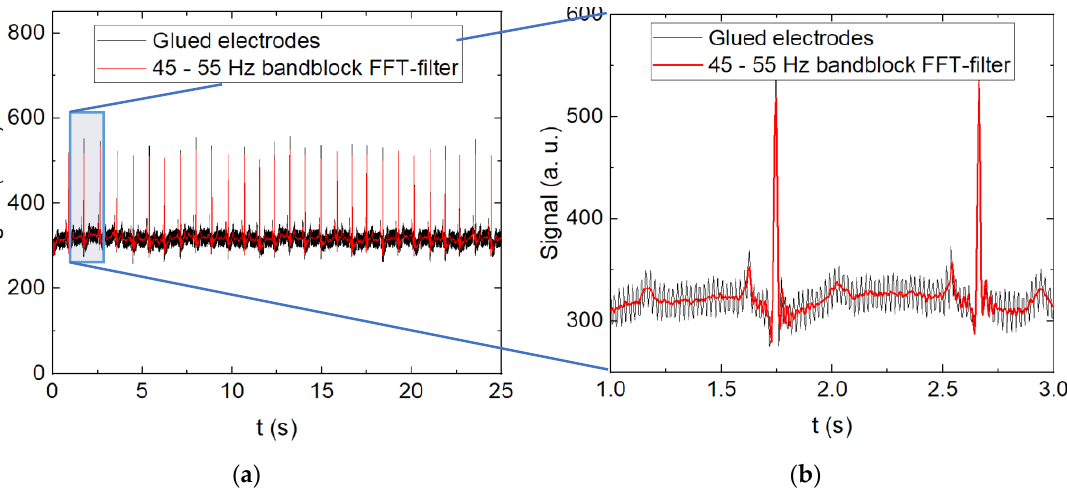
Figure 4. ECG measurement with glued electrodes: ( a ) complete measurement; ( b ) magnified excerpt of the area marked in ( a ).